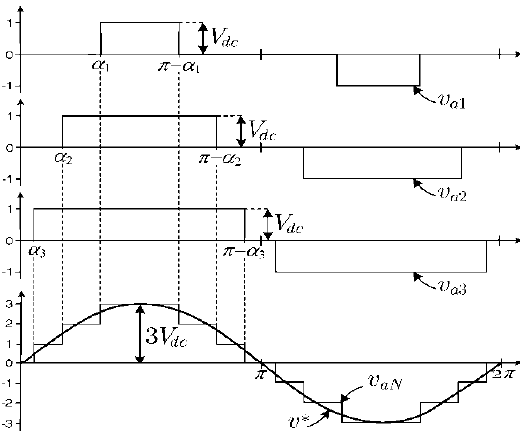
Figure 8. Switching sequence of 1 ∅ Modified 7-Level Inverter